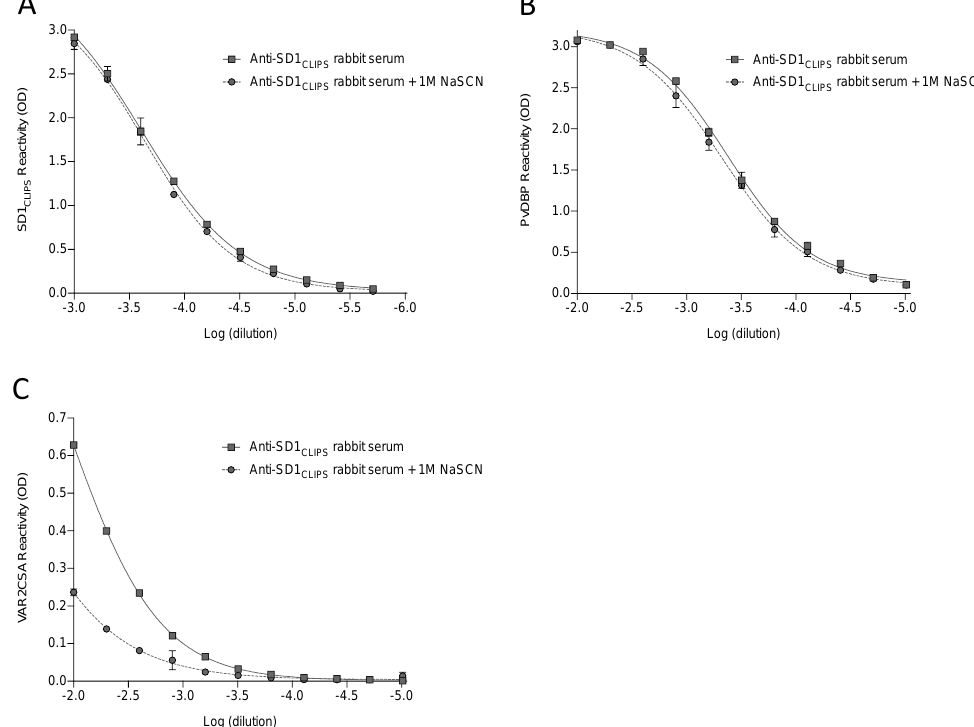
Figure 6. SD1 CLIPS elicits cross-reactive antibodies in a rabbit. The avidity of the anti-SD1 CLIPS rabbit serum against ( A ) SD1 CLIPS , ( B ) DBPII, and ( C ) VAR2CSA was determined by titrating the serum against the antigen with and without the addition of 1 M NaSCN. Data are mean ± SD.